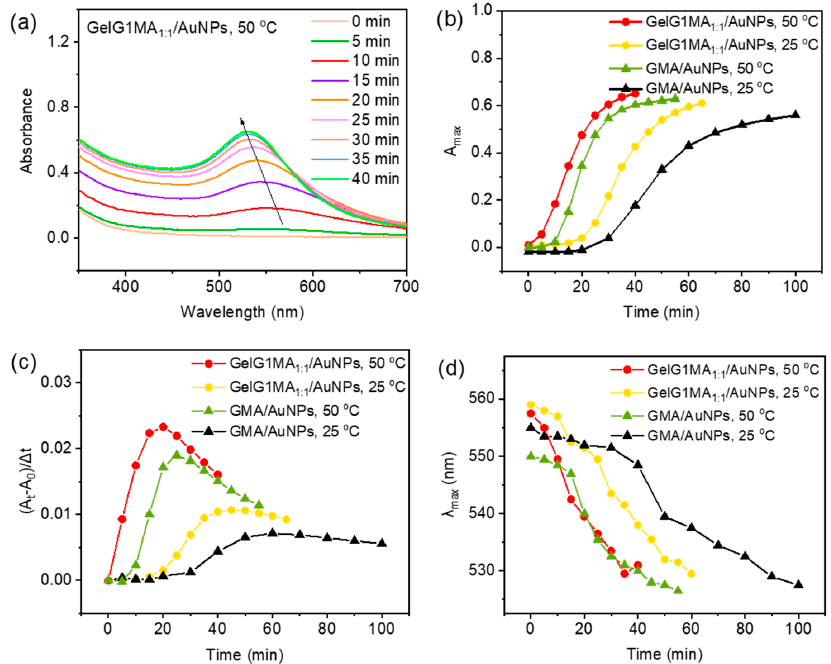
Figure 6. ( a ) UV / vis absorption spectra of AuNPs obtained by in situ reduction of HAuCl 4 (0.1 mg/mL) with GelG1MA 1:1 (2 mg/mL) at 50 °C, and plots of A max ( b ), reduction rate ( c ) and λ max ( d ) with irradiation time for in situ reduction of HAuCl 4 (0.1 mg/mL) with GelG1MA 1:1 and GMA (2 mg/mL) at 50 °C. The data from reduction at 25 °C were also included for better comparison.